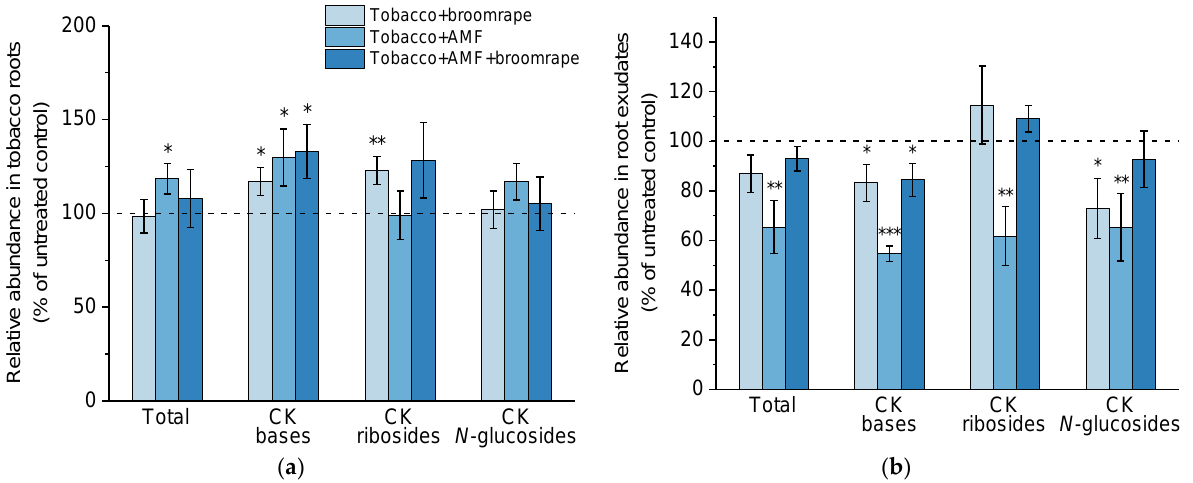
Figure 3. Levels of cytokinin (CK)-related metabolites in roots ( a ) and exudates ( b ) of tobacco plants upon broomrape infestation and/or colonization with arbuscular mycorrhizal fungi (AMF). The total CK content represents the sum of all detected CK-related metabolites in roots and root exudates, respectively (see Section 2.1.3). Values are relative to the non-infested and non-inoculated control (dashed line), and are means of four biological repeats (i.e., independent experiments), with three plants per variant analyzed within each repeat. Error bars indicate standard error of the mean (SE). *** p < 0.001, ** p < 0.01, and * p < 0.05 (Student’s t -test).